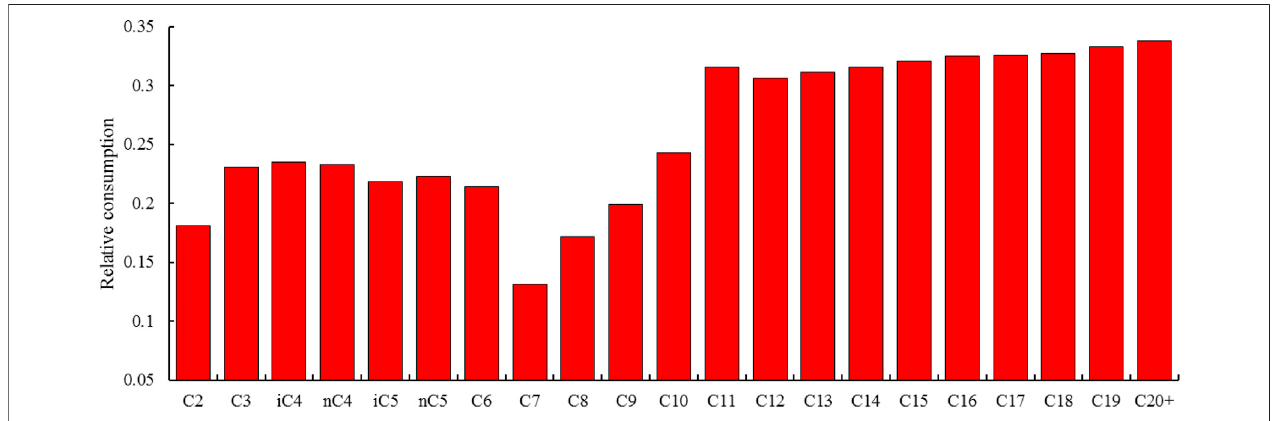
FIGURE 14 | The relative consumption of heavy hydrocarbon components in